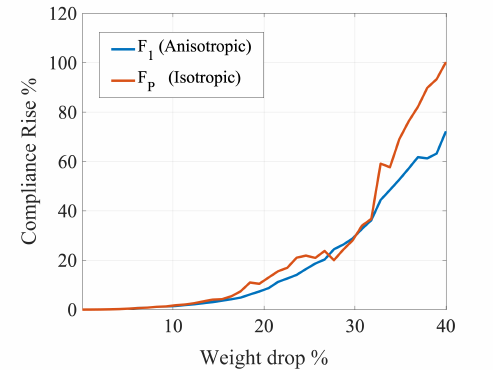
Figure 17. The change of structural compliance with the reduce of the structure’s weight using isotropic and orthotropic cellular